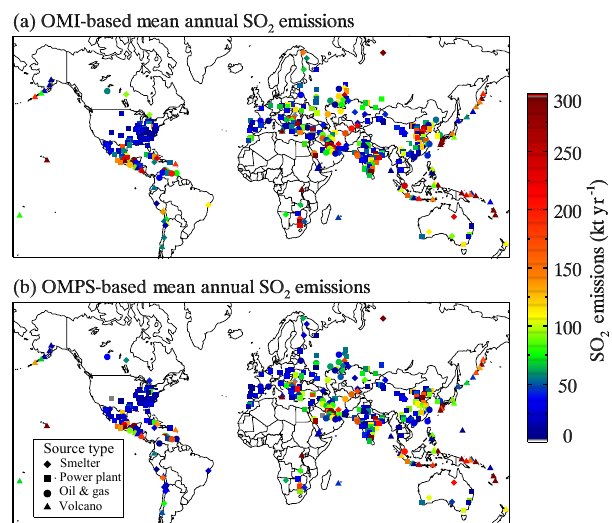
Figure 8. (a) Average annual SO 2 emissions during 2012–2015 estimated from the operational OMI PCA PBL SO 2 retrievals for 403 point sources worldwide. (b) Same as panel (a) but with emis- sions estimated from OMPS retrievals. Color represents the magni- tude of the estimated emissions while source types are marked with different